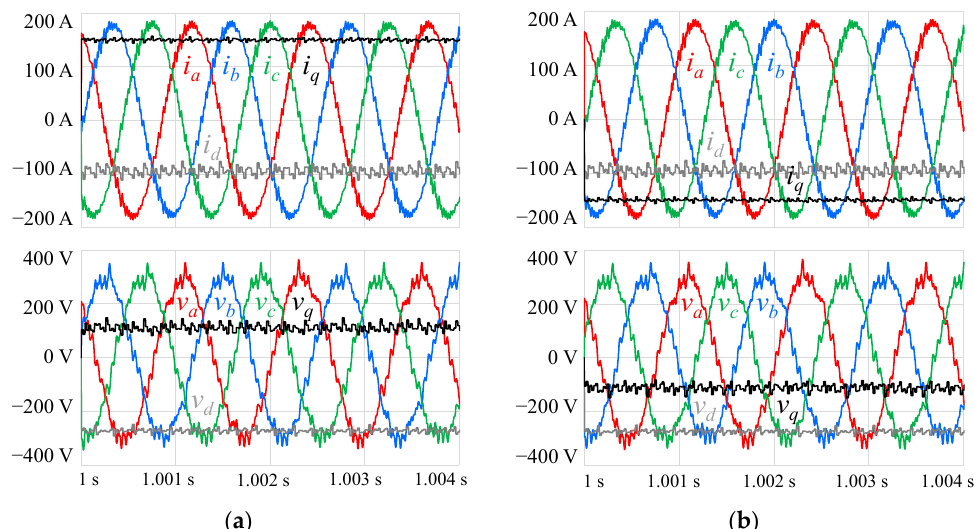
Figure 4. Simulation results of the stator winding voltages ( v a , v b , v c , v d , v q ) and currents ( i a , i b , i c , i d , i q ), applying Park’s transform with the electric machine operating as a motor at nominal speed (12 krpm), coupled with a 50 Nm load, rotating in the directions conventionalized as ( a ) positive and ( b )